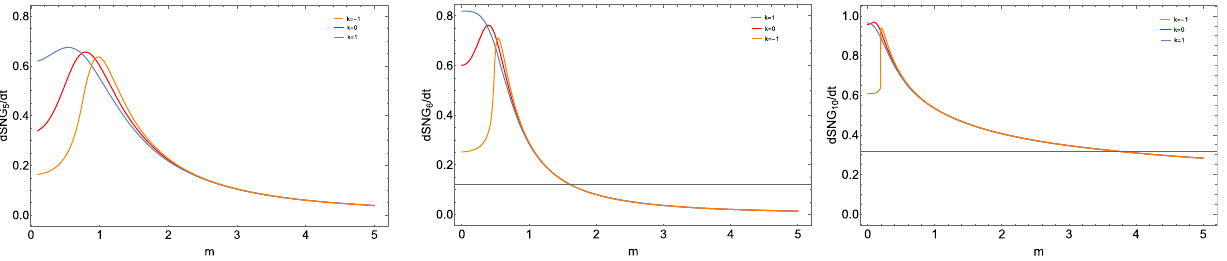
Fig. 11 Action growth v.s. graviton mass for massive AdS black hole From left to right, the dimension is 5 , 6 and 10. In all cases, we have set the black hole mass m 0 = 2 and the string speed is v = 0 .